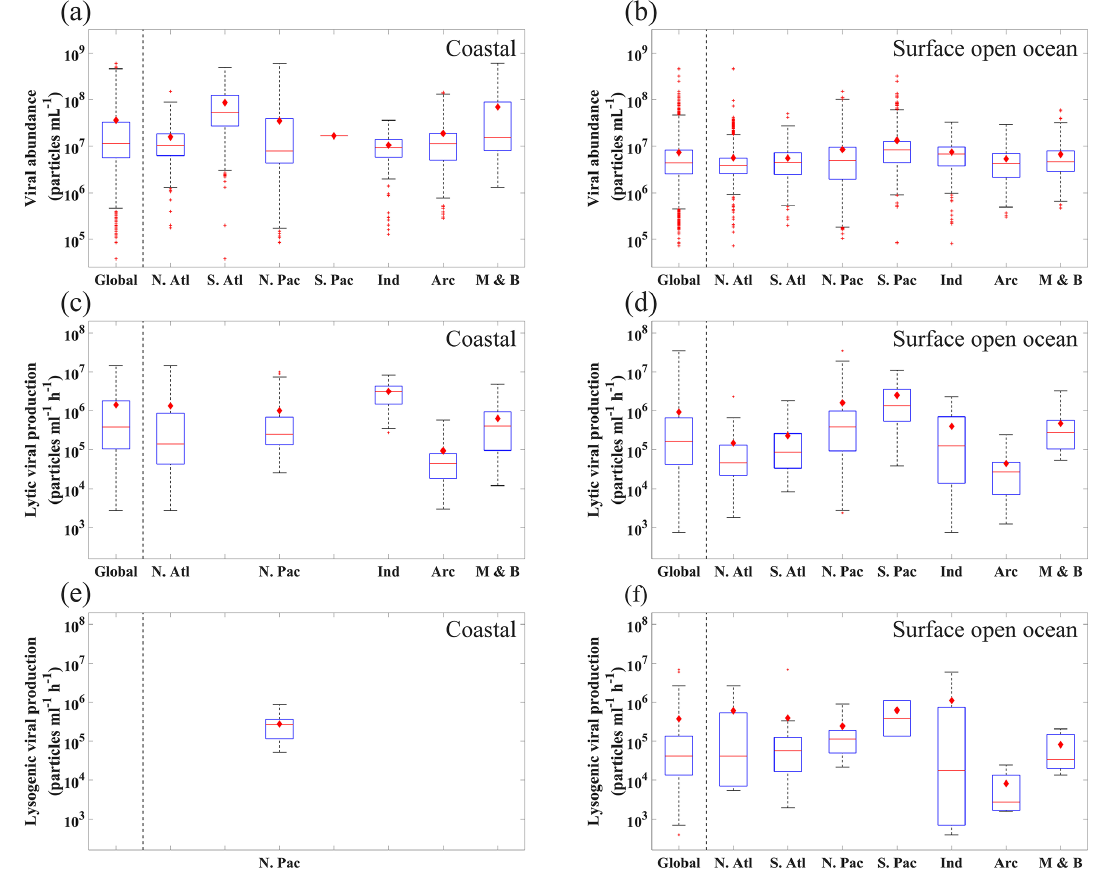
Figure 6. The range of (a, b) viral abundance, (c, d) lytic viral production and (e, f) lysogenic viral production in the different oceans (N. Atl: North Atlantic, S. Atl: South Atlantic, N. Pac: North Pacific, S. Pac: South Pacific, Ind: Indian Ocean, Arc: Arctic Ocean, M & B: Mediterranean Sea and Baltic Sea), grouping in coastal ocean (a–c) and open-ocean samples in surface ( ≤ 200m) waters (d–f) . All data are shown in logarithmic scales. The red diamonds mark the mean value. The central red lines indicate the median, and the bottom and top edges of the box indicate the 25th and 75th percentiles of the data. Error bars extend to the 5th and 95th percentiles, and the remaining outliers are marked with red plus